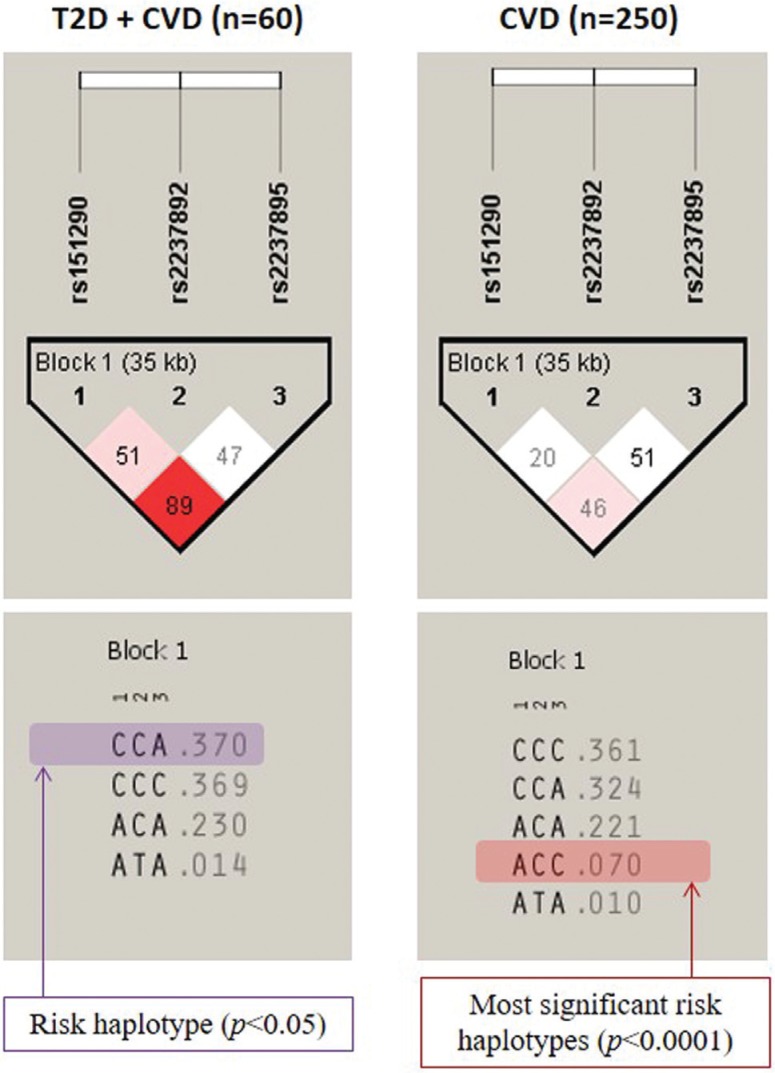
HaploView analysis of KCNQ1 SNPs; block 1 comprises SNPs rs151290, rs2237892 and rs2237895 (35kb). Red or pink block, D' (linkage disequilibrium) < 1.0, with LOD score > 2.0; white blocks, D' < 1.0 with LOD score < 2.0